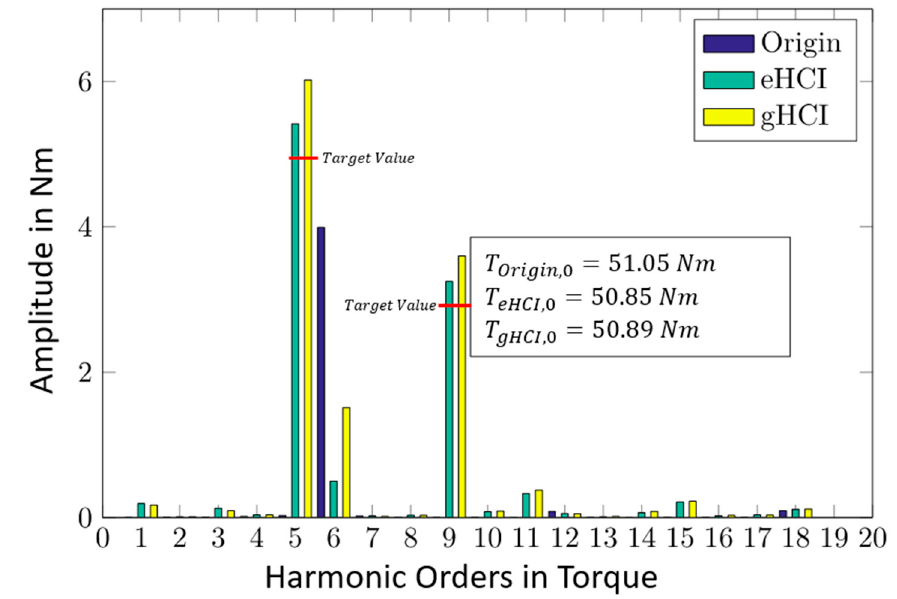
Figure 8. Order spectrum for scenario S4. For better readability, the bars for the zeroth order have been hidden and indicated by their numerical values. Extended harmonic current injection (eHCI) corresponds to the method from Section 3. Generative harmonic current injection (gHCI) corresponds to the approach from [24].